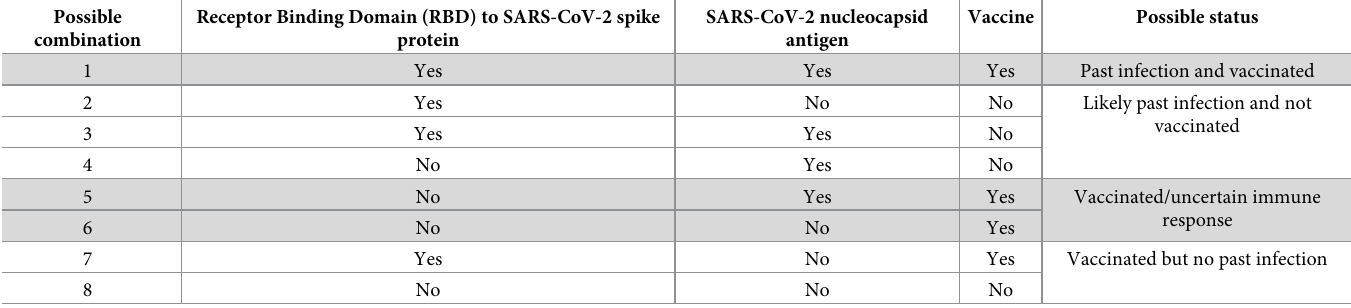
Table 1. Distinction between natural immunity from SARS-CoV-2 infection and acquired immunity from vaccination, based on vaccination status, ELISA RBD antibody assay, and Abbott architect SARS-CoV-2 IgG assay targeting the nucleocapsid protein. Possible Receptor Binding Domain (RBD) to SARS-CoV-2 spike combination